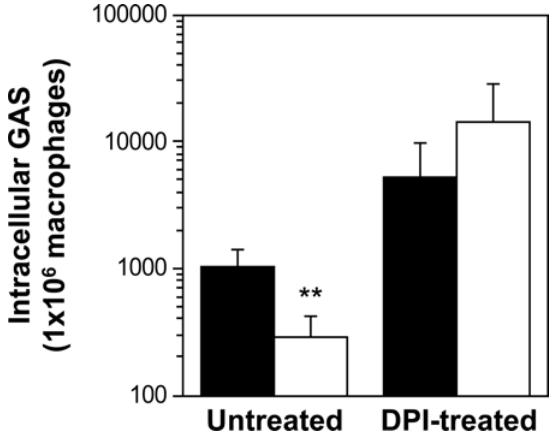
Figure 2. Attenuated survival of the GAS perR mutant inside macrophages is rescued by inhibition of the macrophage oxidative burst. Mouse RAW246.7 macrophages were infected for 1 h with wild-type strain 003Sm (black bars) or perR mutant strain 003Sm perR D (white bars) and then treated with penicillin-gentamicin for an additional hour in the absence (untreated) or presence (DPI- treated, 10 m M) of the general respiratory burst inhibitor DPI. Following the 1 h treatment, intracellular GAS were recovered and enumerated by quantitative culture. Note that DPI treatment rescues attenuated survival of the perR mutant evident in the absence of the inhibitor. ** p , 0.04 for comparison of 003Sm perR D versus 003Sm cfu (Student’s t - test).